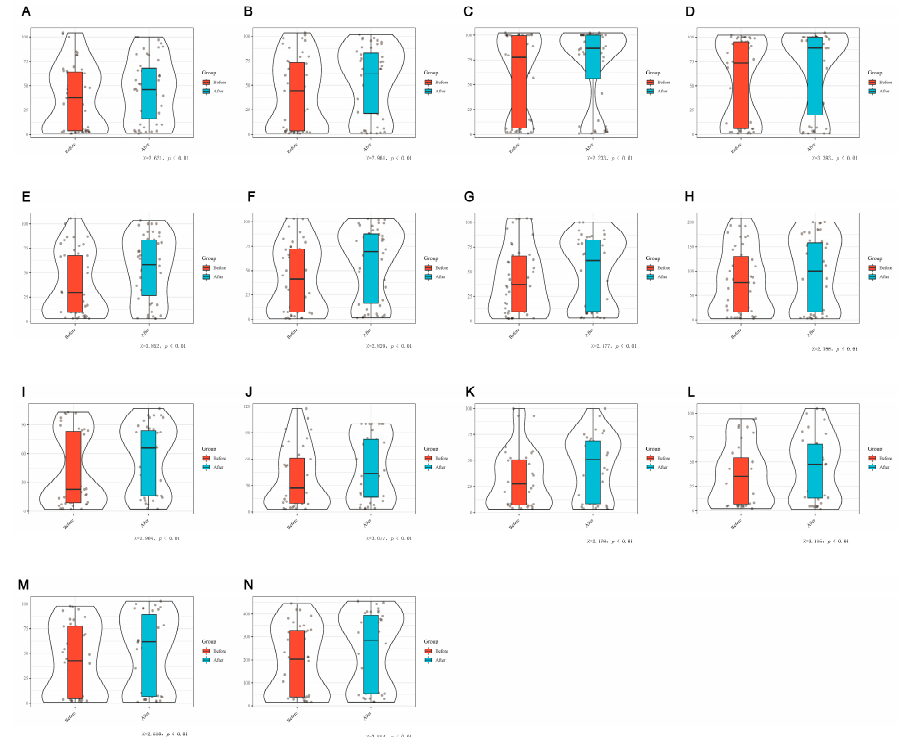
Figure 10. Comparison of differences before and after rehabilitation treatment using MDIVQAS. ( A ) Wrist ulnar deviation; ( B ) Wrist dorsiextension; ( C ) Forearm pronation; ( D ) Forearm supination; ( E ) Cylindrical grip; ( F ) Spherical grip; ( G ) Thumb abduction; ( H ) Thumb flexion and extension; ( I ) Thumb rotation; ( G ) Finger adduction and abduction 1; ( K ) Finger adduction and abduction 2; ( L ) Finger adduction and abduction 3; ( M ) Finger adduction and abduction 4; ( N ) Sum of finger adduction and abduction. Z represents the effect size of the two ‐ sample K – S test (see